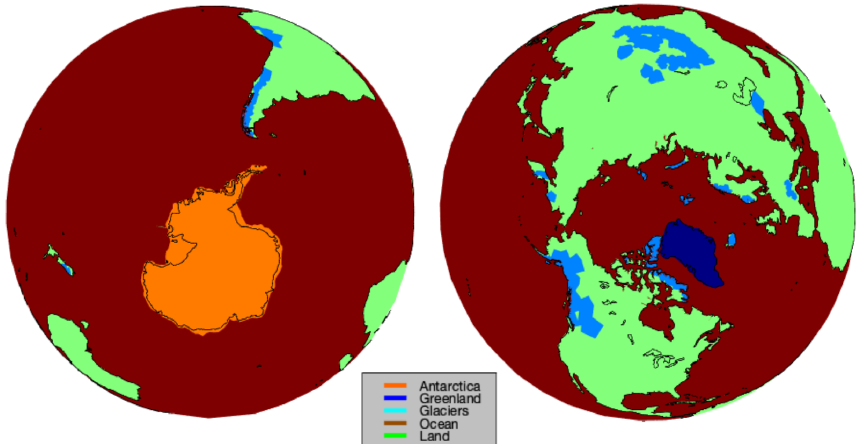
Figure 7. Partition vector (values from 1 to 5: 1 for Antarctica, 2 for Greenland, 3 for glaciers around the world, 4 for the ocean and 5 for ice-free land). The partition vector is used to sample probabilistic variables in a geographically consistent way, with PDF distribution moments (mean and standard deviation) defined for each partition